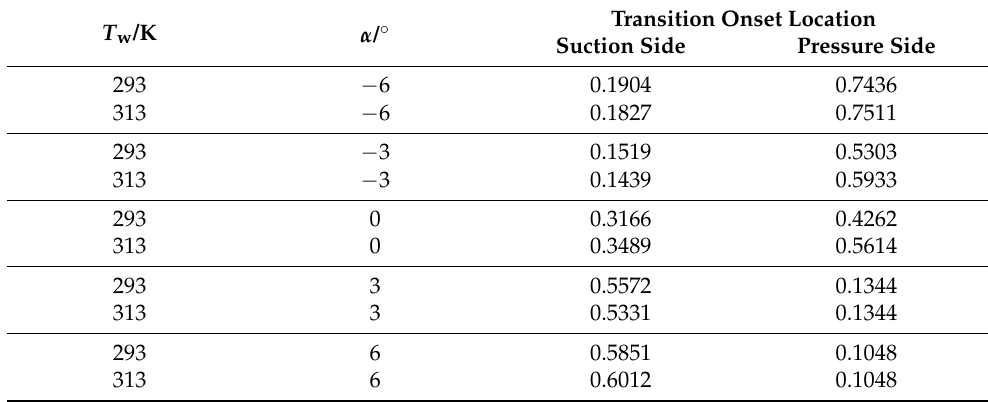
Table A5. Influence of surface temperature on transition onset location ( ε = 0.5%, Ma = 0.75).